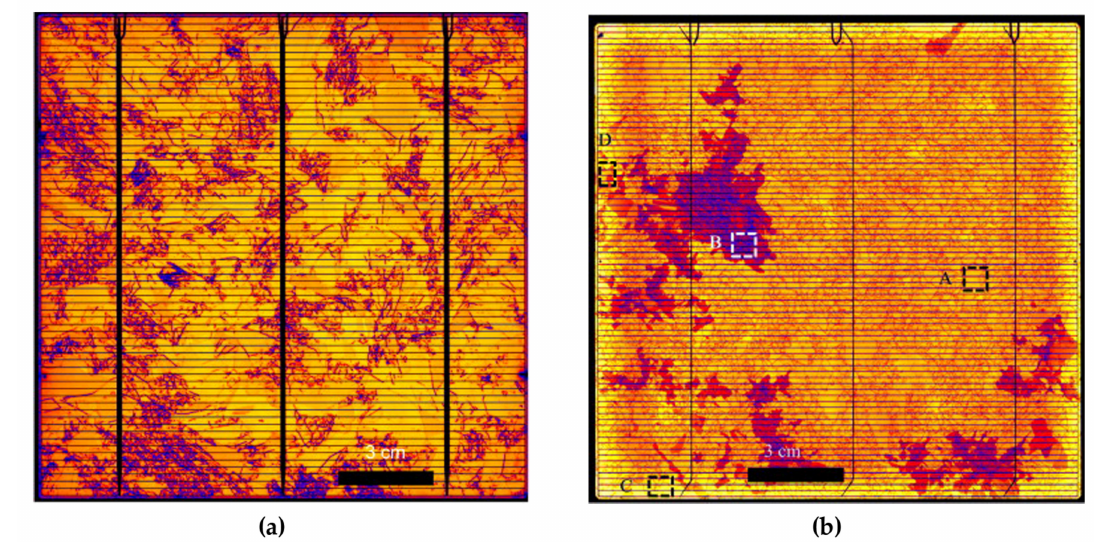
Figure 5. External quantum efficiency maps for healthy and faulty industrial solar cells: ( a ) ordinary map of a healthy cell; ( b ) map of a PV cell under short-circuit conditions. Reproduced from [37], Elsevier: